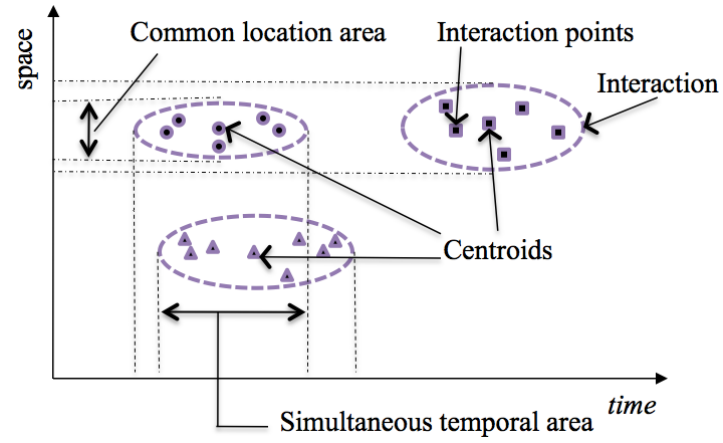
Figure 3. Graph with examples of information read or calculated by the system and stored in the smart phone. It represents an example of Interaction Points for three different Interactions, each one represented by a different